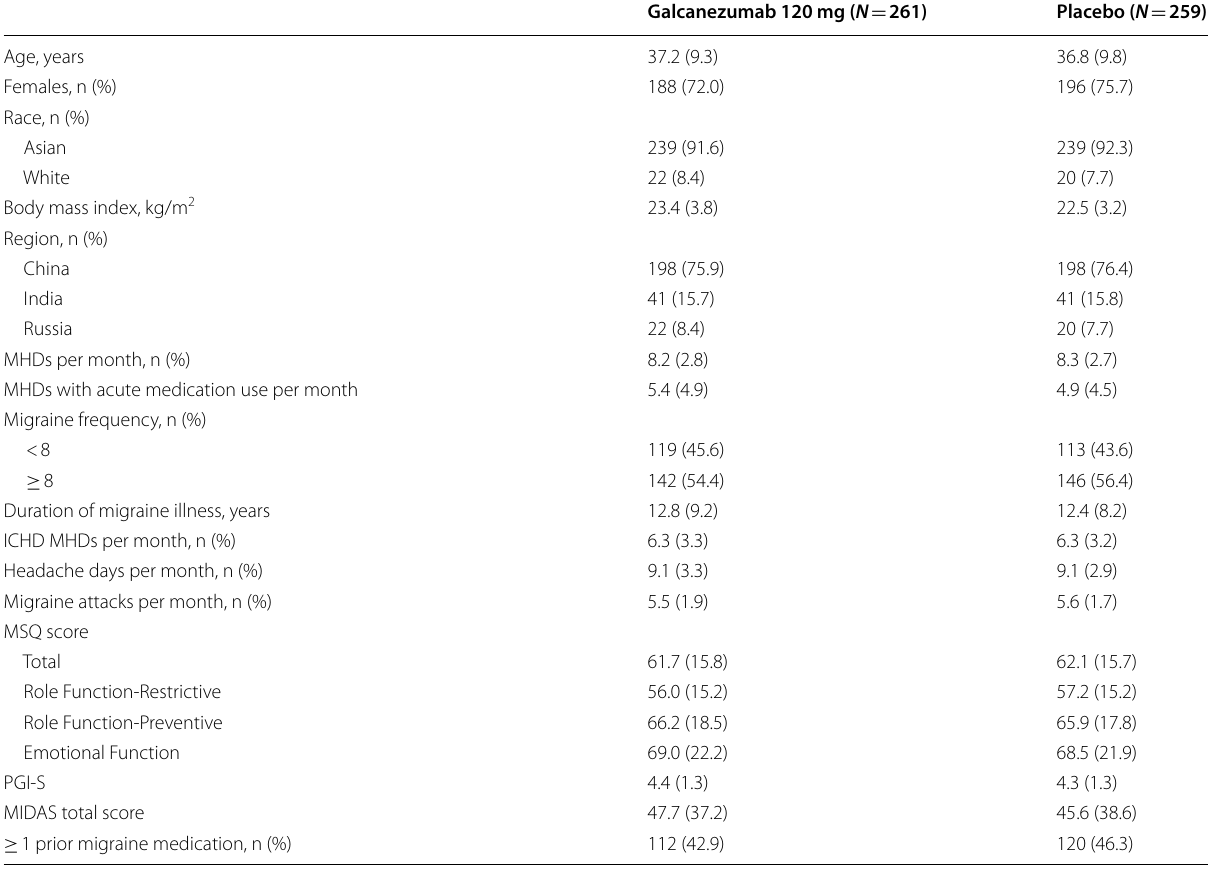
Data are presented as mean (standard deviation) unless otherwise specified ICHD International Classification of Headache Disorders, MHD Migraine headache day, MIDAS Migraine Disability Assessment, MSQ Migraine Specific Quality of Life Questionnaire, N Number of patients in the analysis population, n number of patients within each specific category, PGI-S Patient Global Impression of